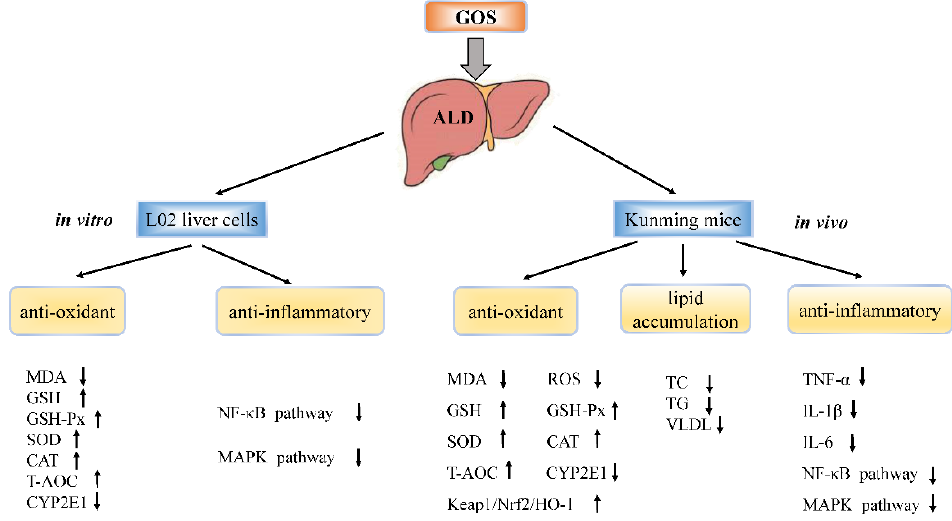
Figure 11. Possible mechanisms by which GOS alleviates ALD. Notes: ↑ indicates increase; ↓ indi- cates inhibition.